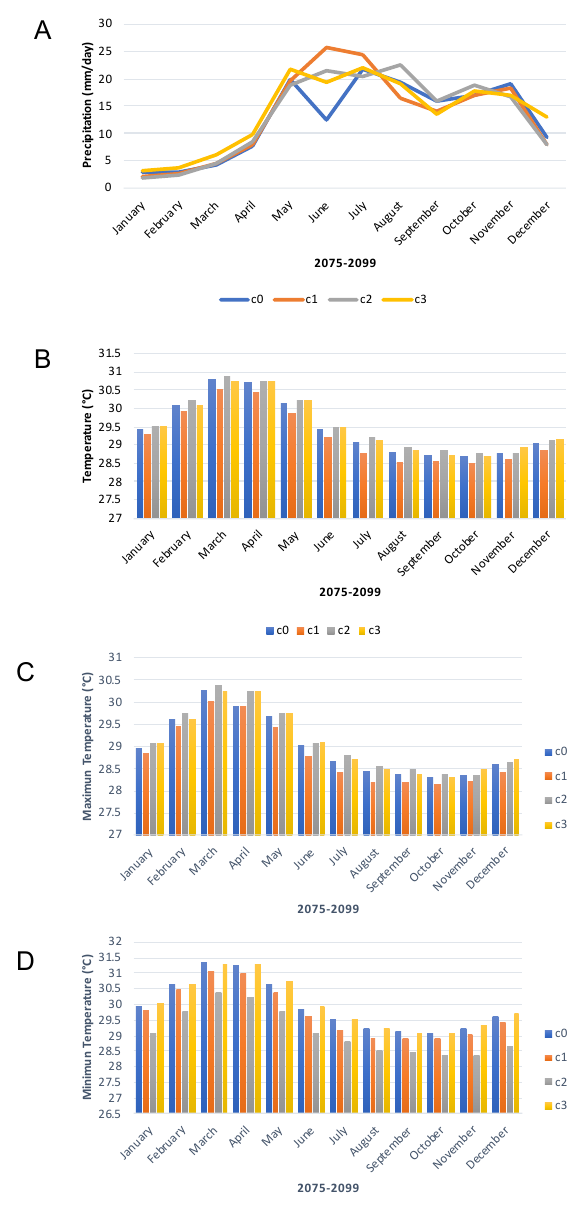
Figure 3. Comparison of monthly averages in the 2075–2099 period under different SST schemes (C0 and C1) and the RCP8.5 trajectory. Precipitation month by month ( A ), Average Temperature month by month ( B ), and Minimum and Maximum Temperature for C0 and C1 SST Schemes ( C , D